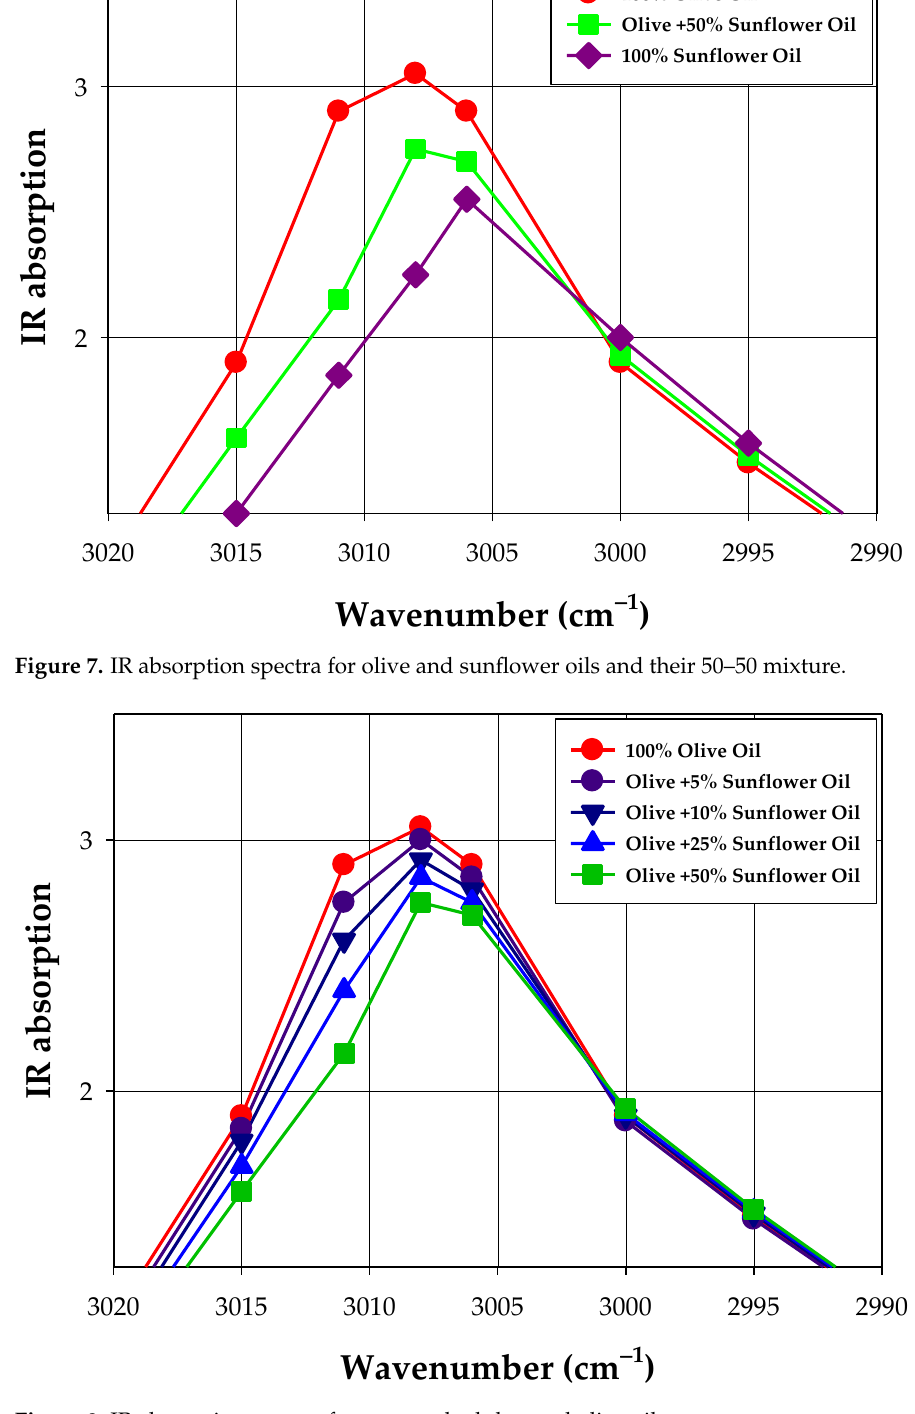
Figure 8. IR absorption spectra for pure and adulterated olive oil.